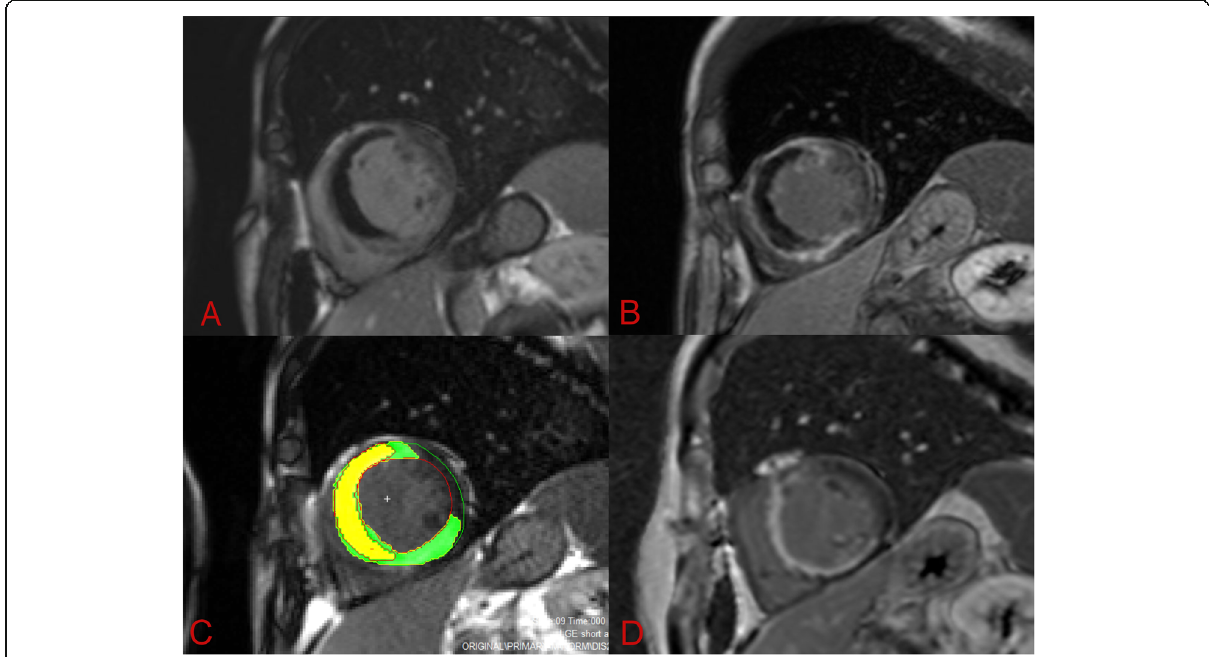
Fig. 8 a Cardiac MR performed for a patient 5 days post-primary percutaneous coronary intervention. Short-axis EGE sequence showing anterior and entire septal low signal corresponding to a large region of microvascular obstruction. b Corresponding short-axis LGE sequence showing full- thickness hyperenhancement/infarct involving anterior, entire septal, and inferior left ventricular wall. The septal low signal within the infarct corresponds to a large region of microvascular obstruction. Culprit lesion was detected at LAD artery. c : Corresponding Short-axis LGE sequence with post-processing of the LV scar (green) and MVO (yellow) revealing an MVO size = 43% and scar size = 93% of the total left ventricular mass